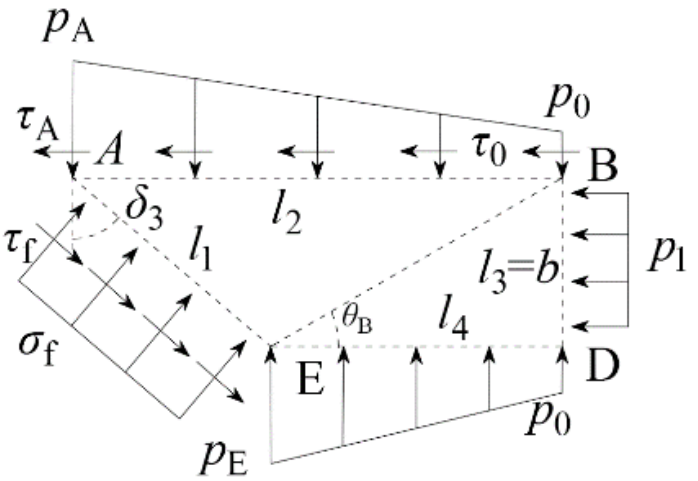
Figure 18. Force in the ABDE area. Next, the normal stress σ f and tangential stress τ f on the AE surface were